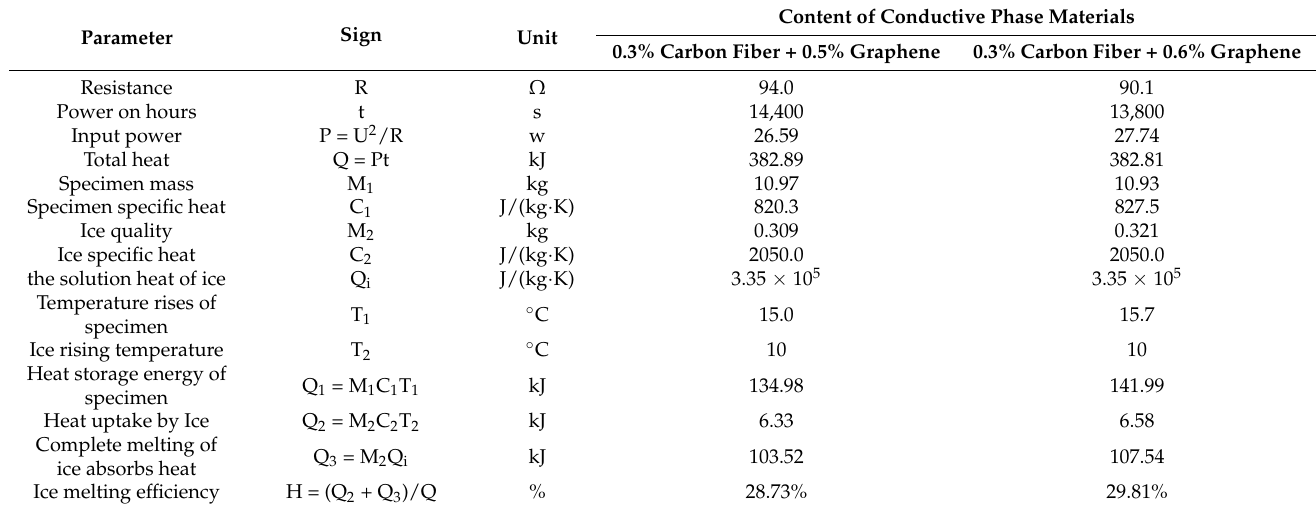
Table 22. Energy calculation of snow and ice melting process simulated by rut plate specimen.